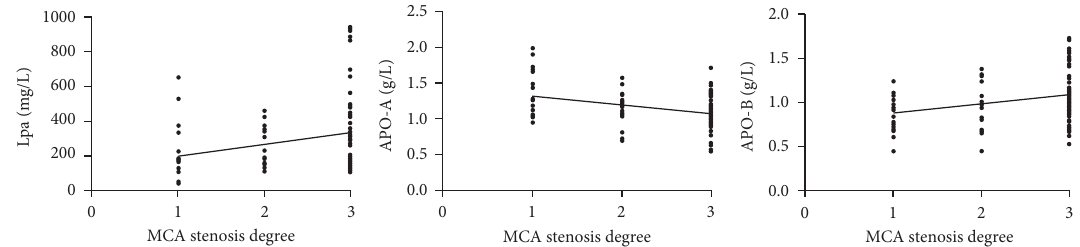
Figure 3: Scatter plot of correlation between Lpa, APO-A, APO-B, and MCA stenosis degree in CIS